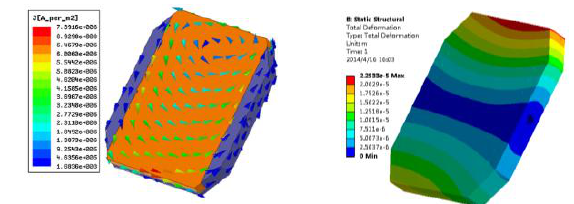
Fig. 6. The distribution of induced eddy current density and the maximum deformation locates on the top of mirror